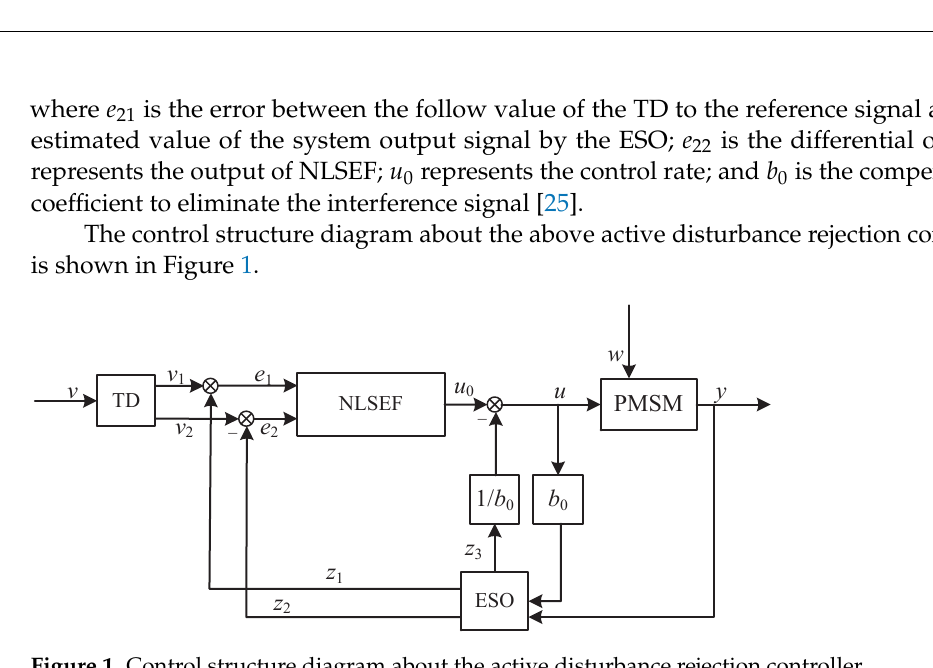
Figure 1. Control structure diagram about the active disturbance rejection